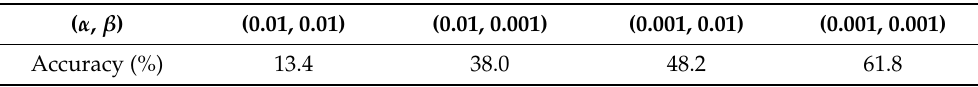
Table 7. Accuracy when applying DIPDefend to adversarial examples of (cid:101) = 8.